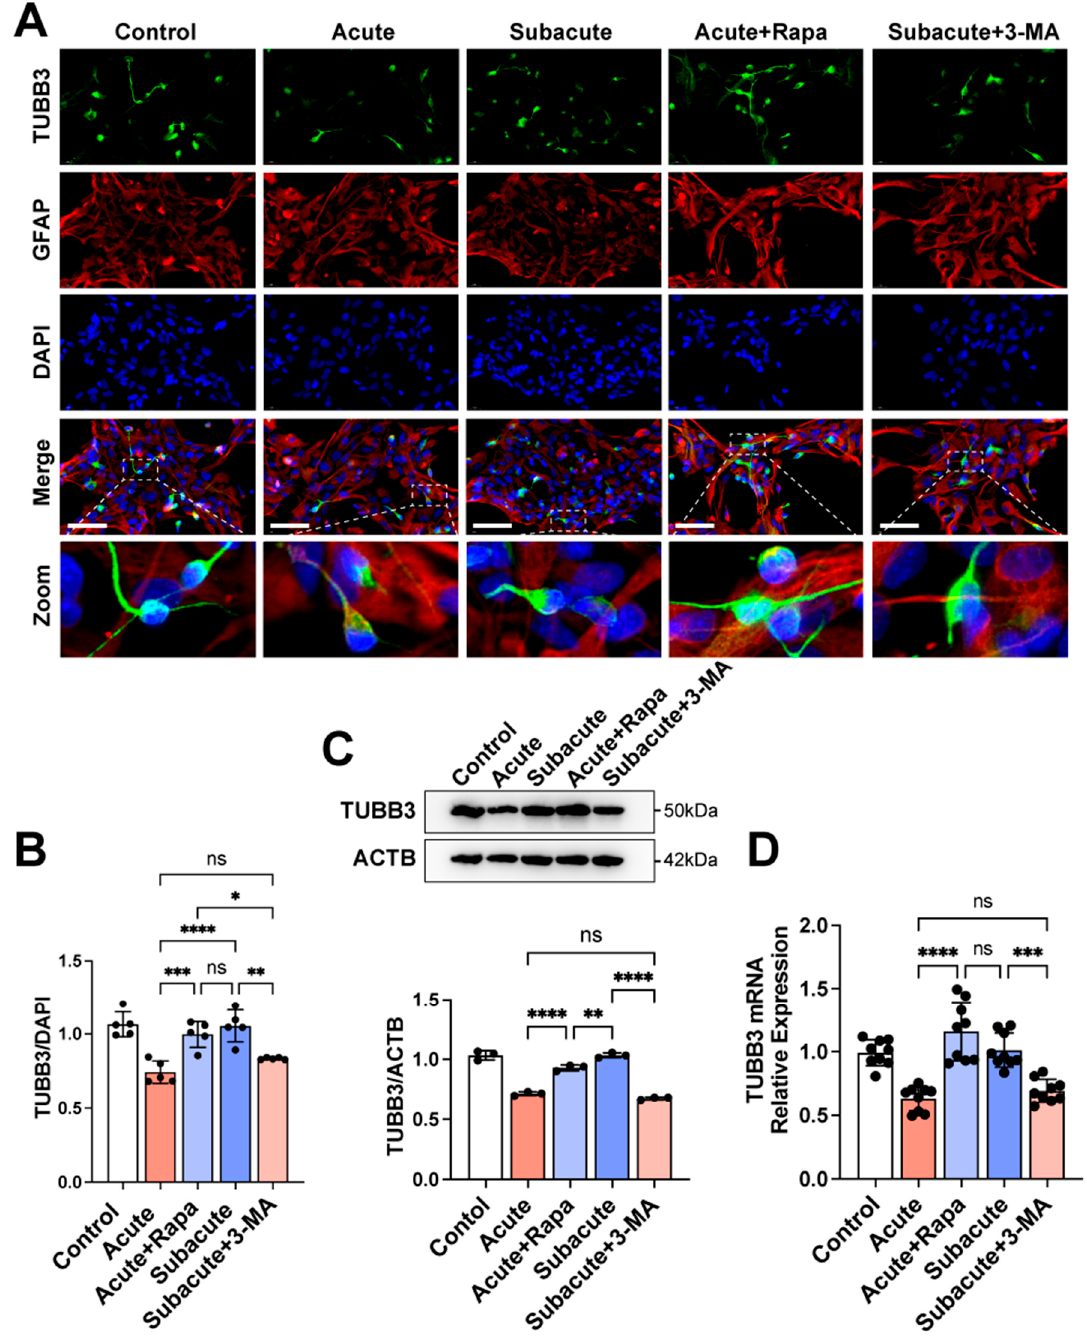
Figure 5. Treating with rapamycin promoted the neuronal differentiation of hNSCs in the acute TBI brain extract. With a treatment of rapamycin (50 nM) or 3-MA (2 μ M), hNSCs could differentiate into TUBB3 + neurons and GFAP + astrocytes in stimulated TBI microenvironments ( A ). The mean fluorescence intensity (MFI) of TUBB3/DAPI showed that the treatment with rapamycin increased neuronal differentiation in the acute phase, while treating with 3-MA in the subacute phase decreased neuronal differentiation ( B ). Related protein and mRNA expression of TUBB3 also indicated the same result ( C , D ). The black circle in B,C,D represented the individual value of each sample. Bar scale: 50 μ m; *: p < 0.05; **: p < 0.01; ***: p < 0.001; ****: p < 0.0001; ns: p ≥ 0.05.